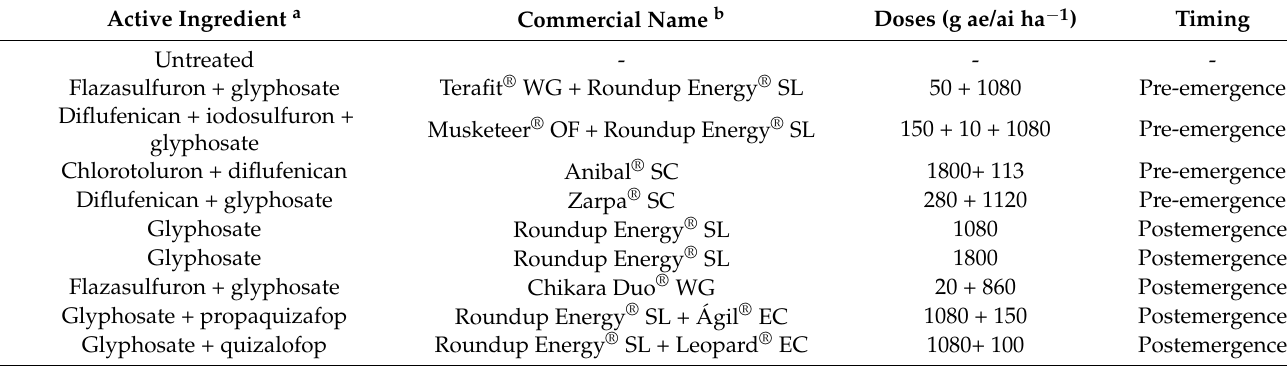
Table 2. Herbicide treatments tested in situ for control effectiveness of glyphosate-resistant Bromus rubens in field. Active Ingredient a Commercial Name